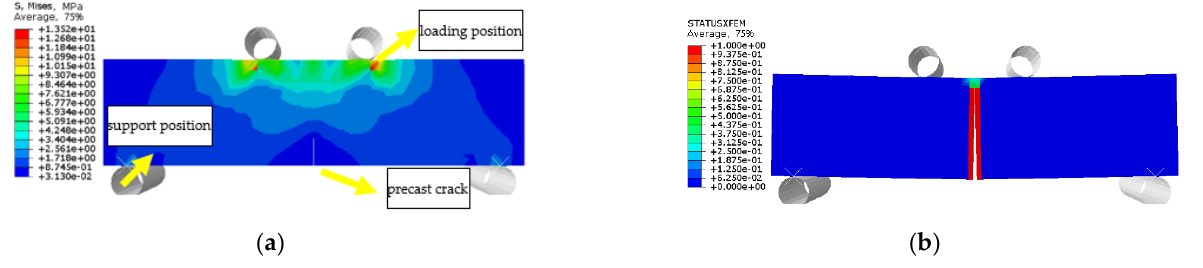
Figure 37. URFND: ( a ) stress nephogram and ( b ) damage nephogram of prefabricated crack.